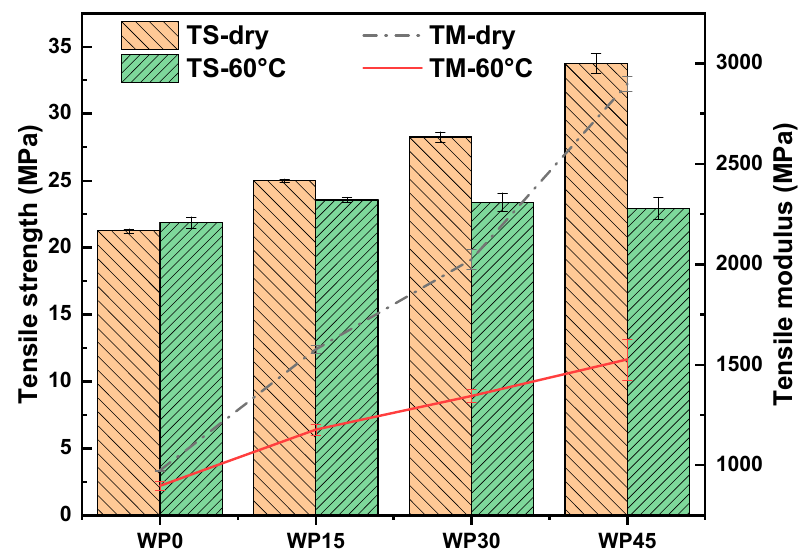
Figure 4. Tensile strength and modulus of samples.